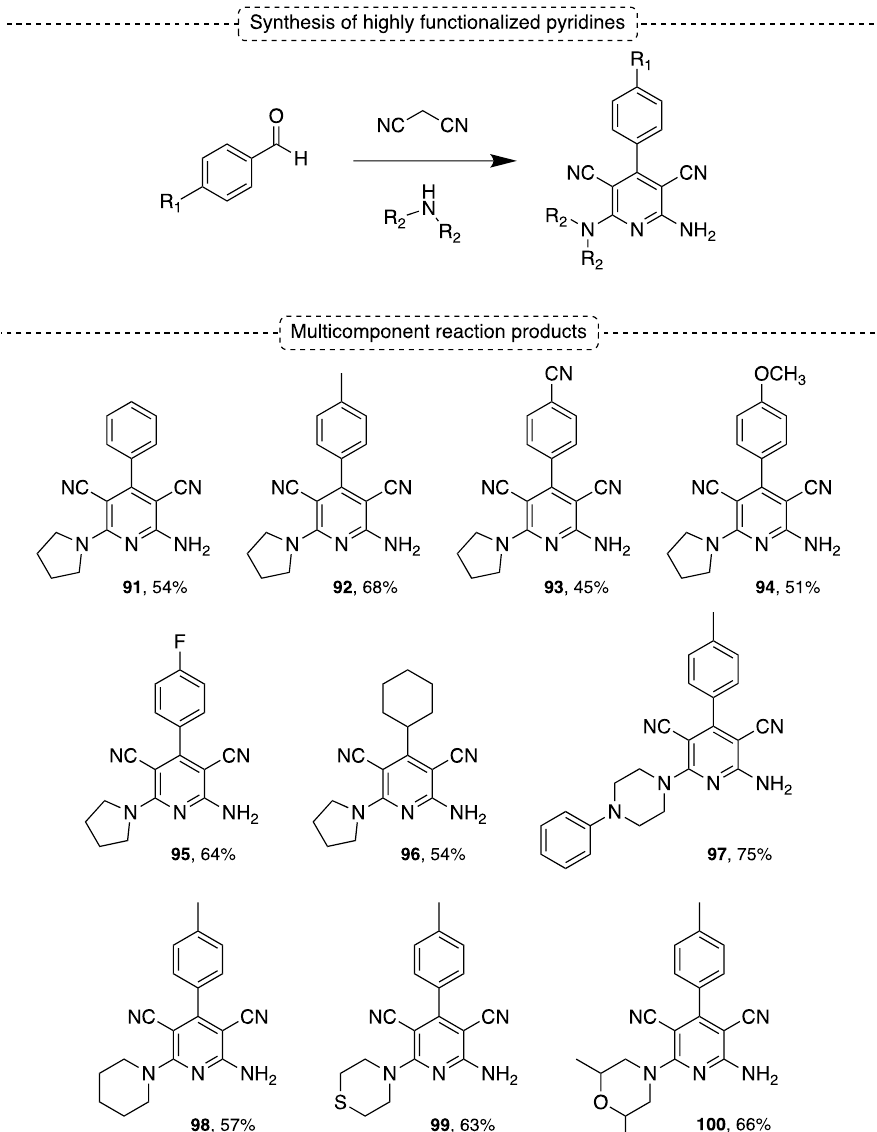
Figure 11. Multicomponent reaction products in eucalyptol [151].